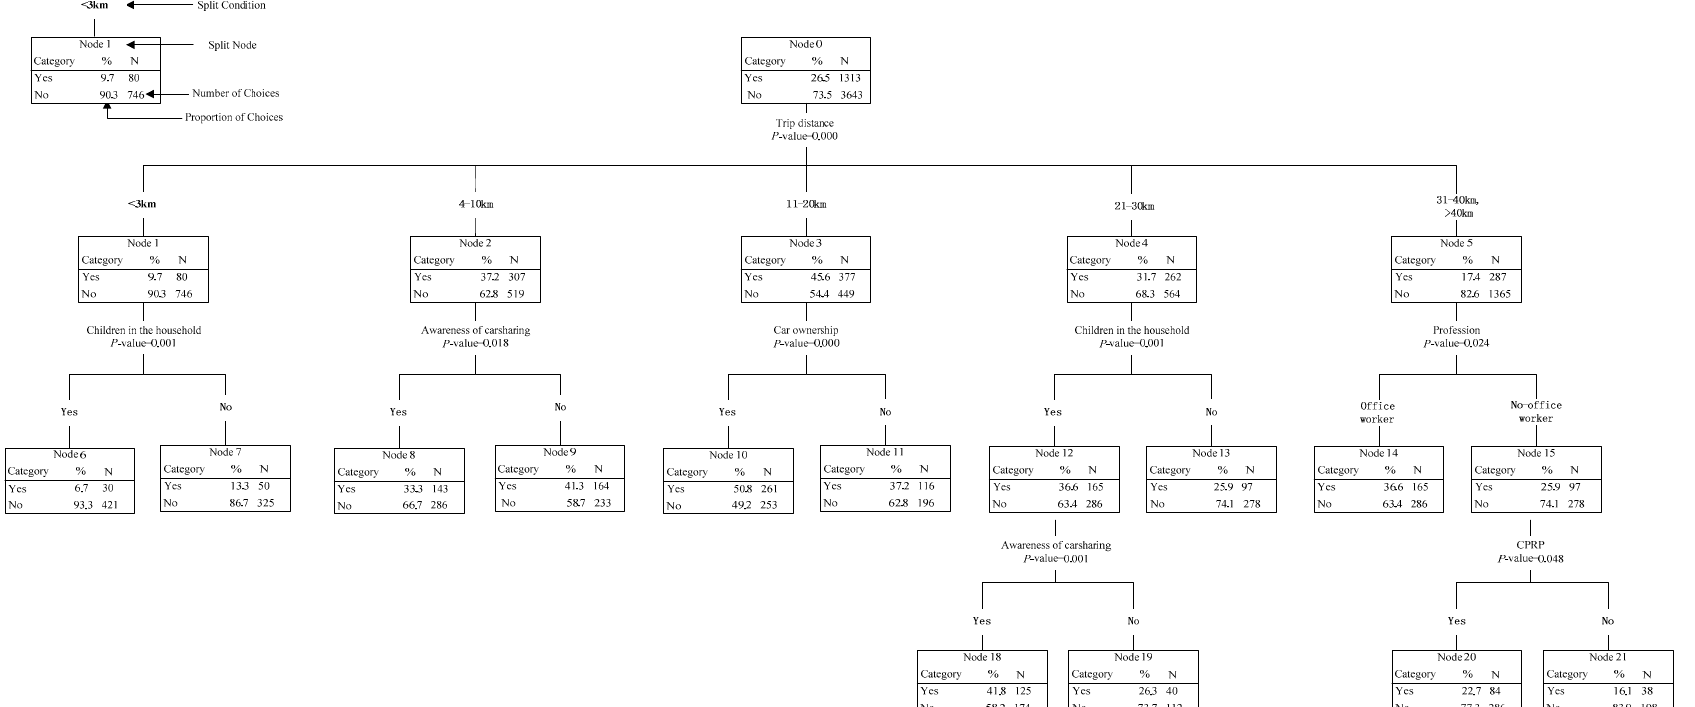
Figure 5. HTBR Model #2: Predicting predicting participants’ carsharing mode choice under different distances.